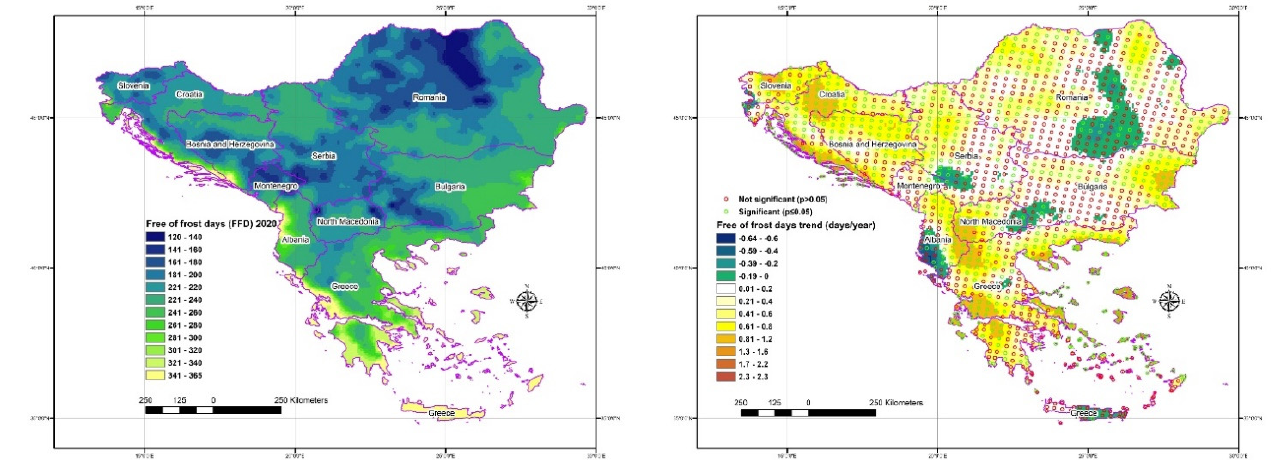
Figure 16. The free of frost days (FFD) in 2020 ( left ) and the FFD trend ( right ). It is worth mentioning that the regions in which a reduction of the free frost period will be shortened are the agricultural zone northern than the Romano-Bulgarian borders and the southern coastal part of Albania. The same trend is calculated for the eastern part of Crete island and a small part of southwestern Serbia. On the other hand, the rest Balkanian area is under a positive trend of FFD, indicating more extended cultivation periods between the LSF and FAF. The median values of the FFD (Table 4) show that the Greek region has a wider free of frost period with 325 days, followed by Albania with 234 days. In comparison, the narrowest free of frost period is recorded over Montenegro and Serbia with 186 and 187 days,